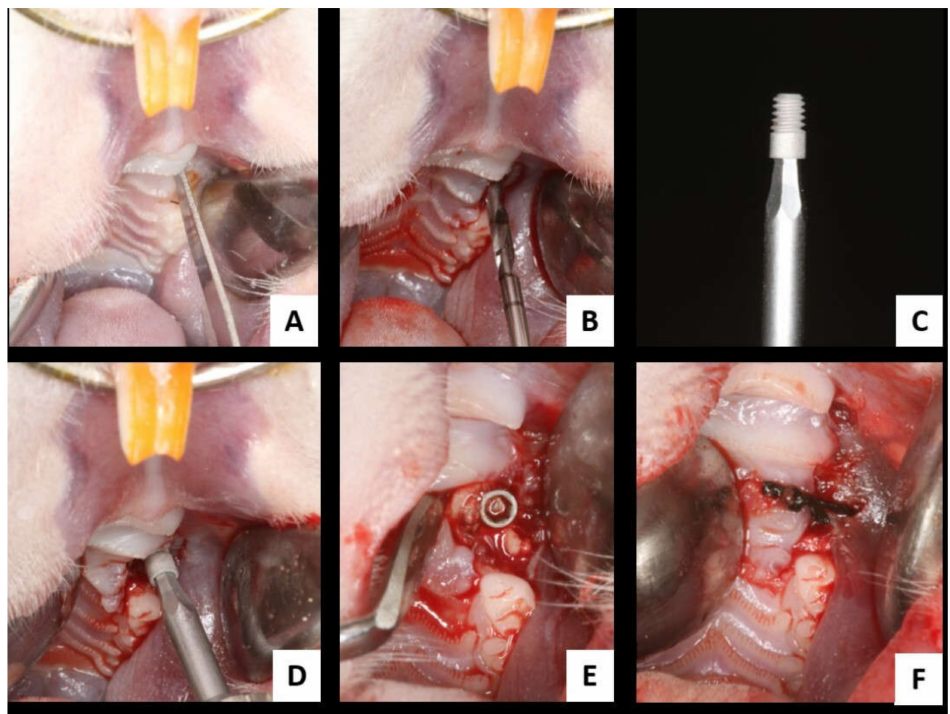
Figure 3. Surgery for installing osseointegrated implants in the maxilla. ( A ) Linear incision on the alveolar ridge of the upper right first molar; ( B ) alveolar bone milling cutter with diameter 1.2 mm; ( C ) implant used in the study; ( D ) osseointegrated implant installation in the maxilla; ( E ) implant installed in the maxilla; ( F ) alveolar mucosa